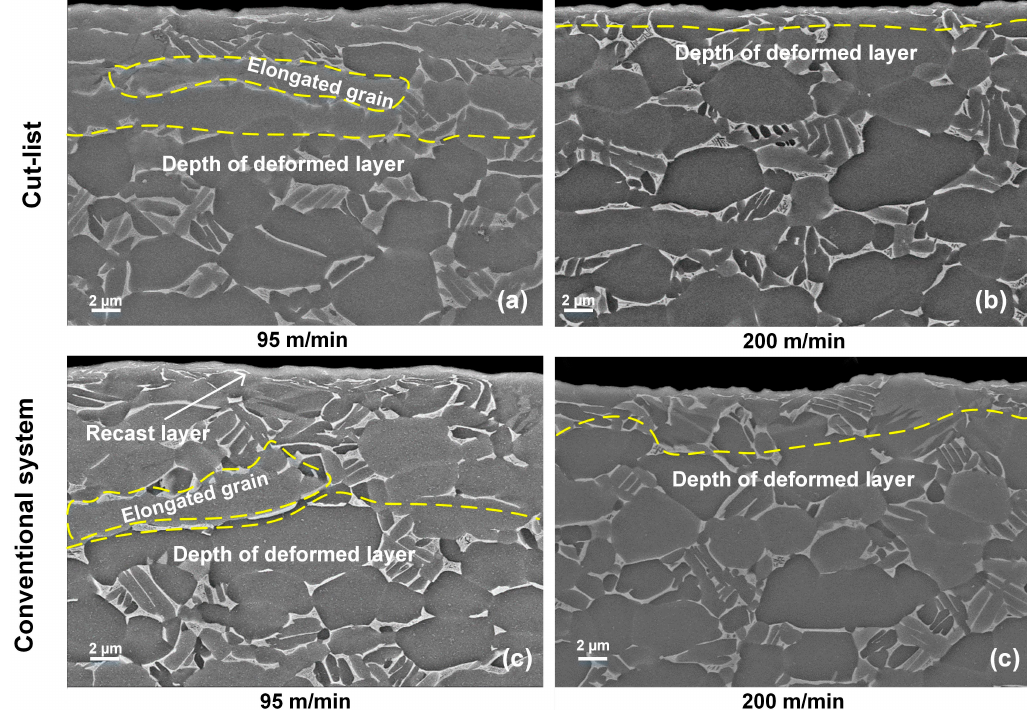
Figure 8. Scanning electron microscope (SEM) images of surface microstructure of machined parts at 0.1 mm/rev feed rate using Cut-list at cutting speeds of ( a , b ) 95 and 200 m/min respectively and the conventional supply system at cutting speeds of ( c , d ) 95 and 200 m/min respectively.